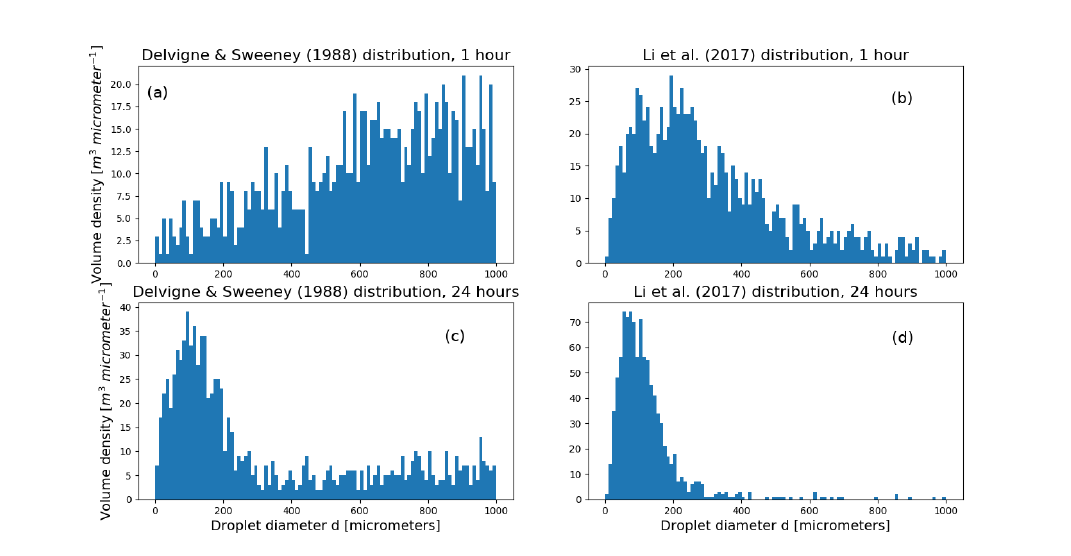
Figure 6. Oil droplet volume histogram for 1000 elements after 1 h using the Light Louisiana Sweet, BP oil type in OpenOil during 8 ms − 1 wind. The initial condition is a uniform distribution. Delvigne and Sweeney [46] ( a ) and Li et al. [42] ( b ). Bottom panels show corresponding distributions after 24